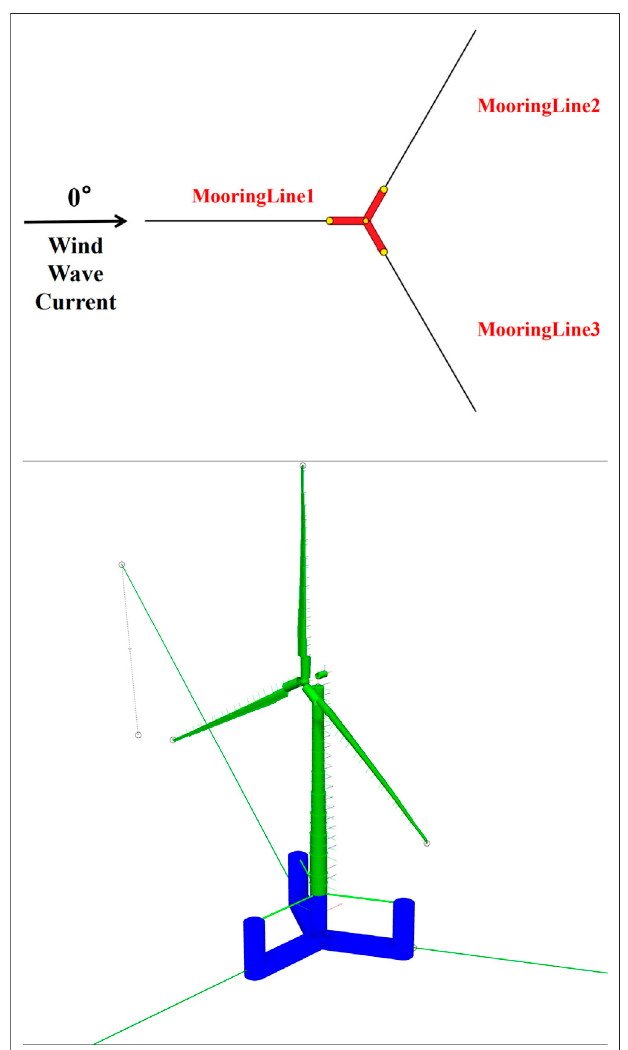
FIGURE 1 | Numerical model of the semi-submersible 15 MW FOWT. (A) Detailed arrangement ofthe mooringlines. (B) Integrated numerical model in